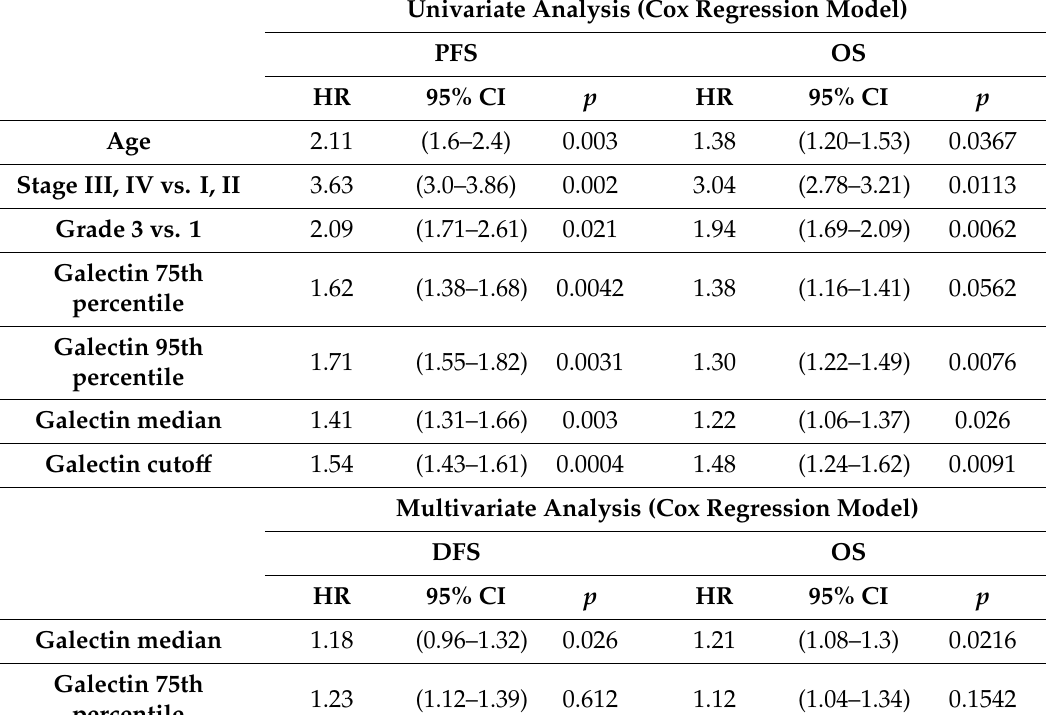
Table 5. Univariate and multivariate statistical